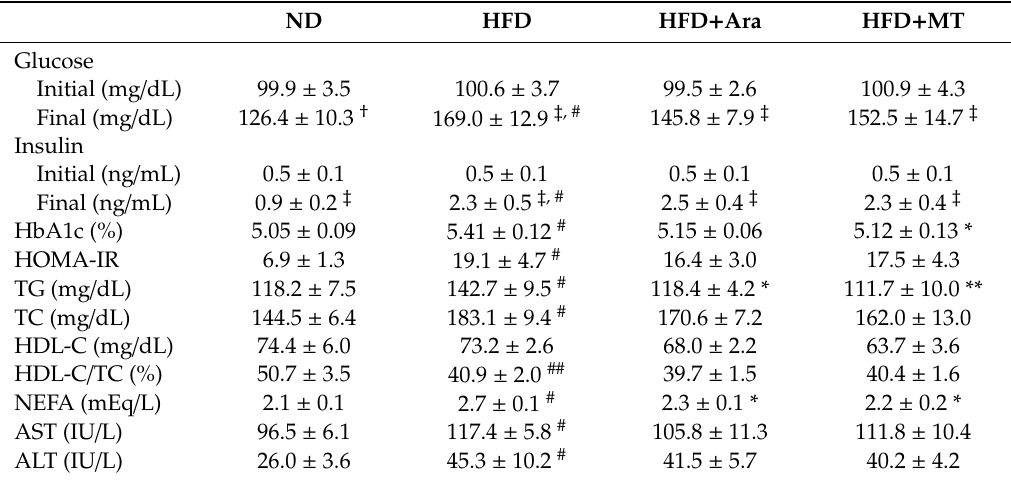
Table 2. Plasma metabolic factor measurements in HFD-fed NAFLD-like mice a